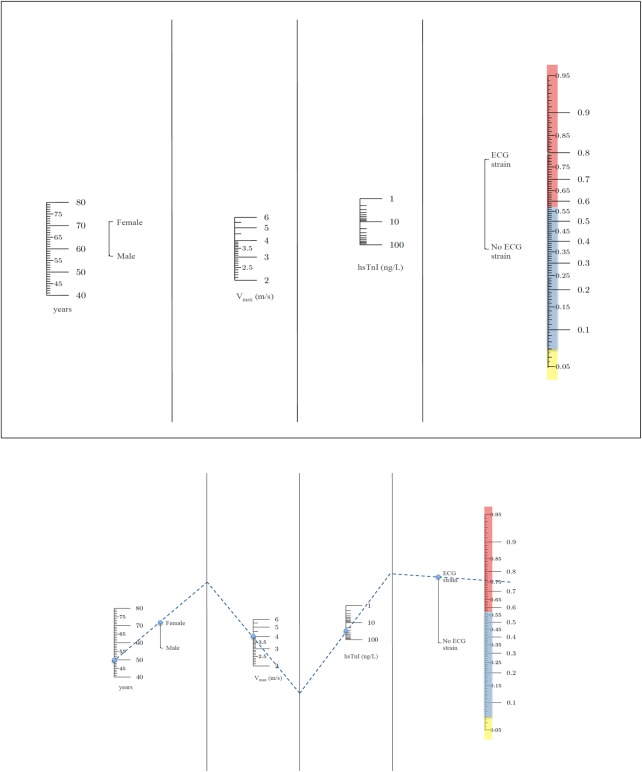
Nomogram for aortic stenosis clinical score. The risk probability can be also
calculated using a nomogram. For example, a 50-year-old female patient with peak
aortic jet velocity of 4.0 m/s, high-sensitivity cardiac troponin concentration of
30 ng/L and electrocardiogram strain pattern would have a risk probability of 78%
(high risk).